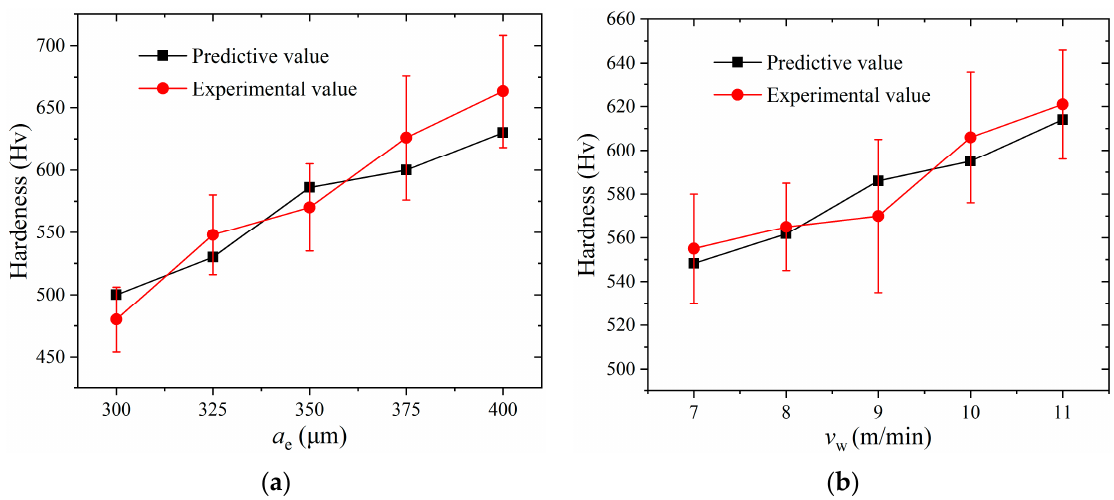
Figure 11. Comparison of the predictive value and experimental value of the surface hardness: ( a ) v w = 9 m/min, v s = 26.4 m/s; ( b ) a e = 350 μ m, v s = 26.4 m/s.